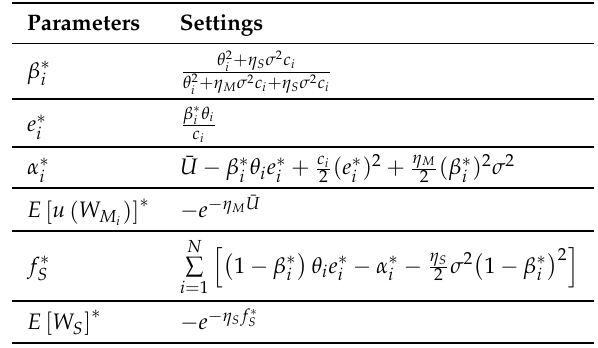
Table 1. Optimal contract design parameters and